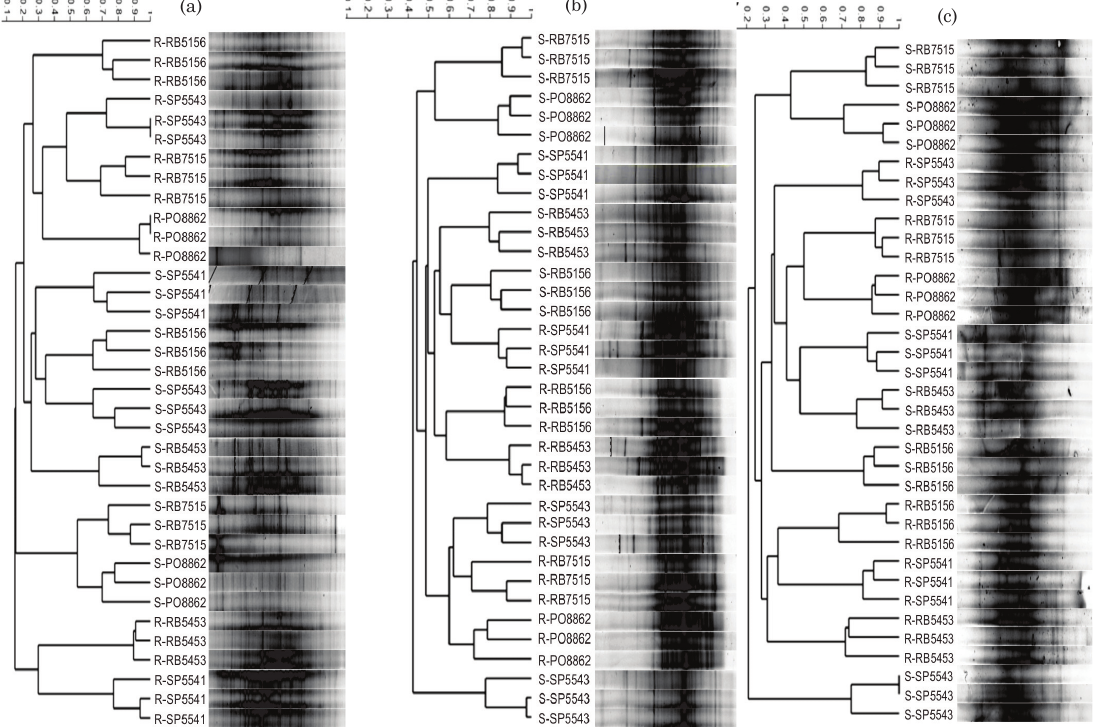
Figura 1. Análise de dendrogramas, por meio da técnica de PCR-DGGE, evidenciando diferenças entre as comunidades bacterianas colonizadoras do solo e da rizosfera de diferentes variedades de cana-de- açúcar: RB86-7515; PO8862; RB85-5156; RB85-5453; SP5541; e SP5543. Os prefixos ‘S’ e ‘R’ significam solo e rizosfera, respectivamente. Os grupos bacterianos foram acessados da comunidade total, por meio de iniciadores específicos para o grupo das bactérias totais (a), Alphaproteobacteria (b) e Betaproteobacteria